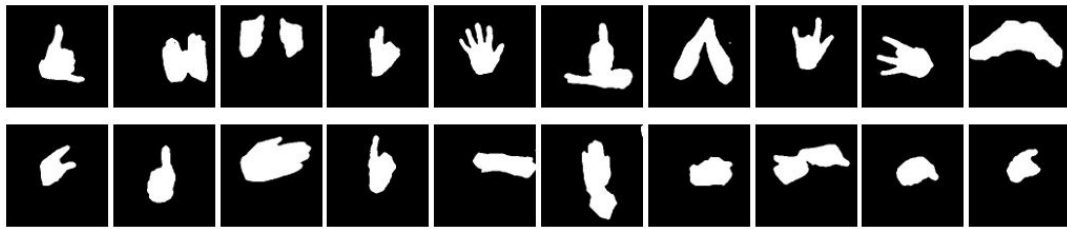
Figure 9. Example of the YCbCr segmented images from the